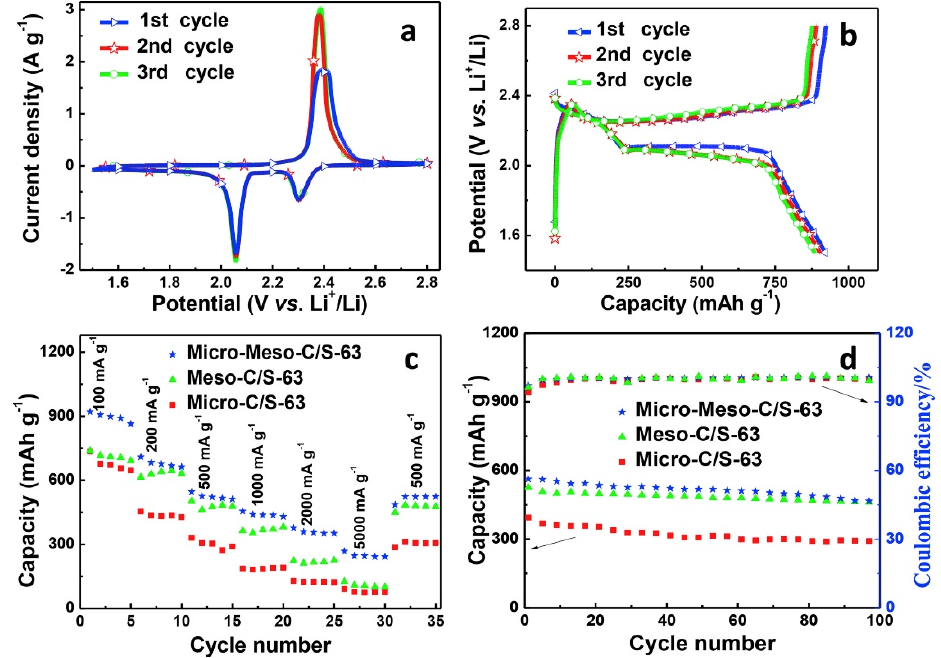
Figure 3. ( a ) Cyclic voltammetry of Micro-Meso-C/S-63 composite cathode at 0.2 mV/s; ( b ) discharge/charge plots of Micro-Meso-C/S-63 composite cathode at 100 mA/g; ( c ) rate capability of lithium cells and ( d ) cyclability of lithium cells at 500 mA/g for Micro-C/S-63, Micro-Meso-C/S-63 and Meso-C/S-63 composite cathodes. Reprinted from [115]. Copyright (2016), with permission from Elsevier.